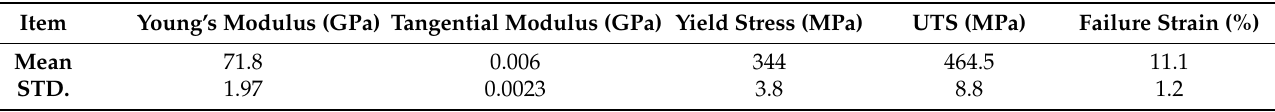
Table 3. Mean characteristics of strain–stress curve in tensile test before